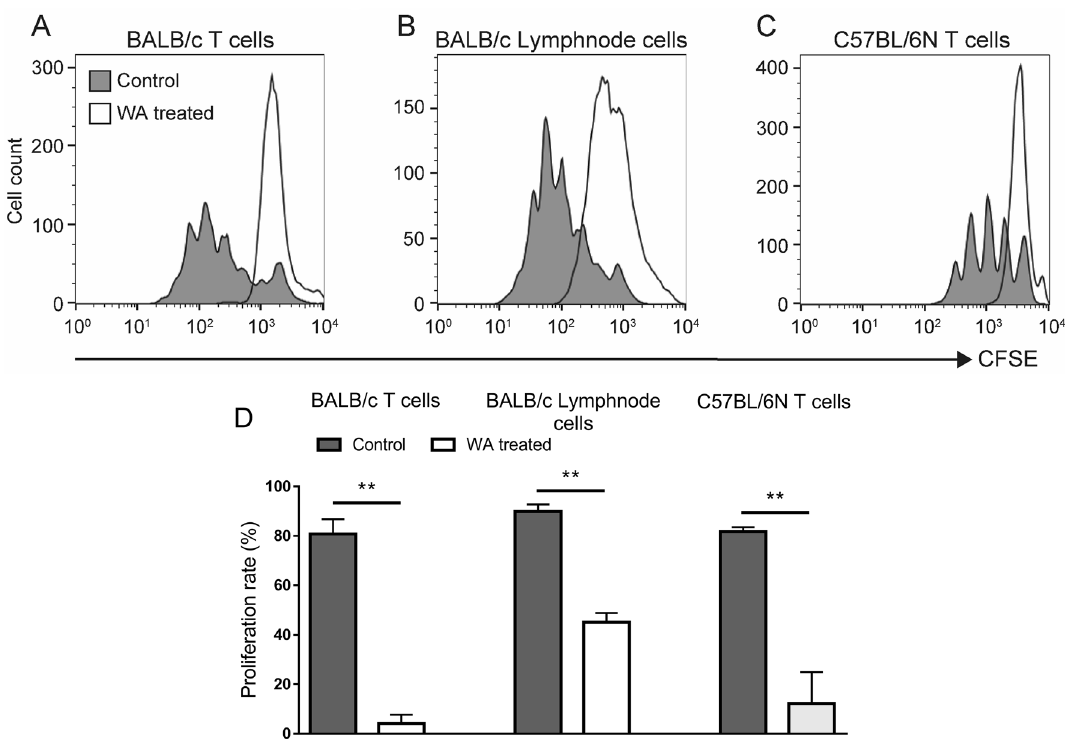
Figure 2. Effects of WA treatment on prevention of stimulated mouse lymphocyte proliferation. CD3 + T cell proliferation detected by flow cytometry analysis of CFSE-stained cells after 5 days of culture for ( A ) T cells from splenocytes isolated from BALB/c mice and stimulated by CD3/CD28 beads with or without WA 0.5 μg/ mL treatment; ( B ) lymph node cells isolated from BALB/c mice and stimulated by CD3/CD28 beads with or without WA 0.5 μg/mL treatment; and ( C ) T cells from splenocytes isolated from C57BL/6N mice and stimulated by CD3/CD28 beads with or without WA 0.5 μg/mL treatment. Representative histograms from three independent experiments are shown. ( D ) Proliferation rate of BALB/c T cells, BALB/c lymphnode cells and C57BL/6N T cells are shown. ** P < 0.01.